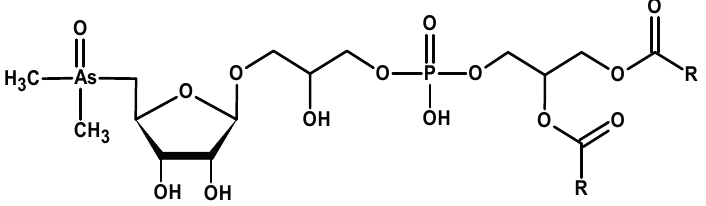
Figure 1. Chemical structure of dimethylarsenoriboside phospholipids (R—a carbon chain of fatty